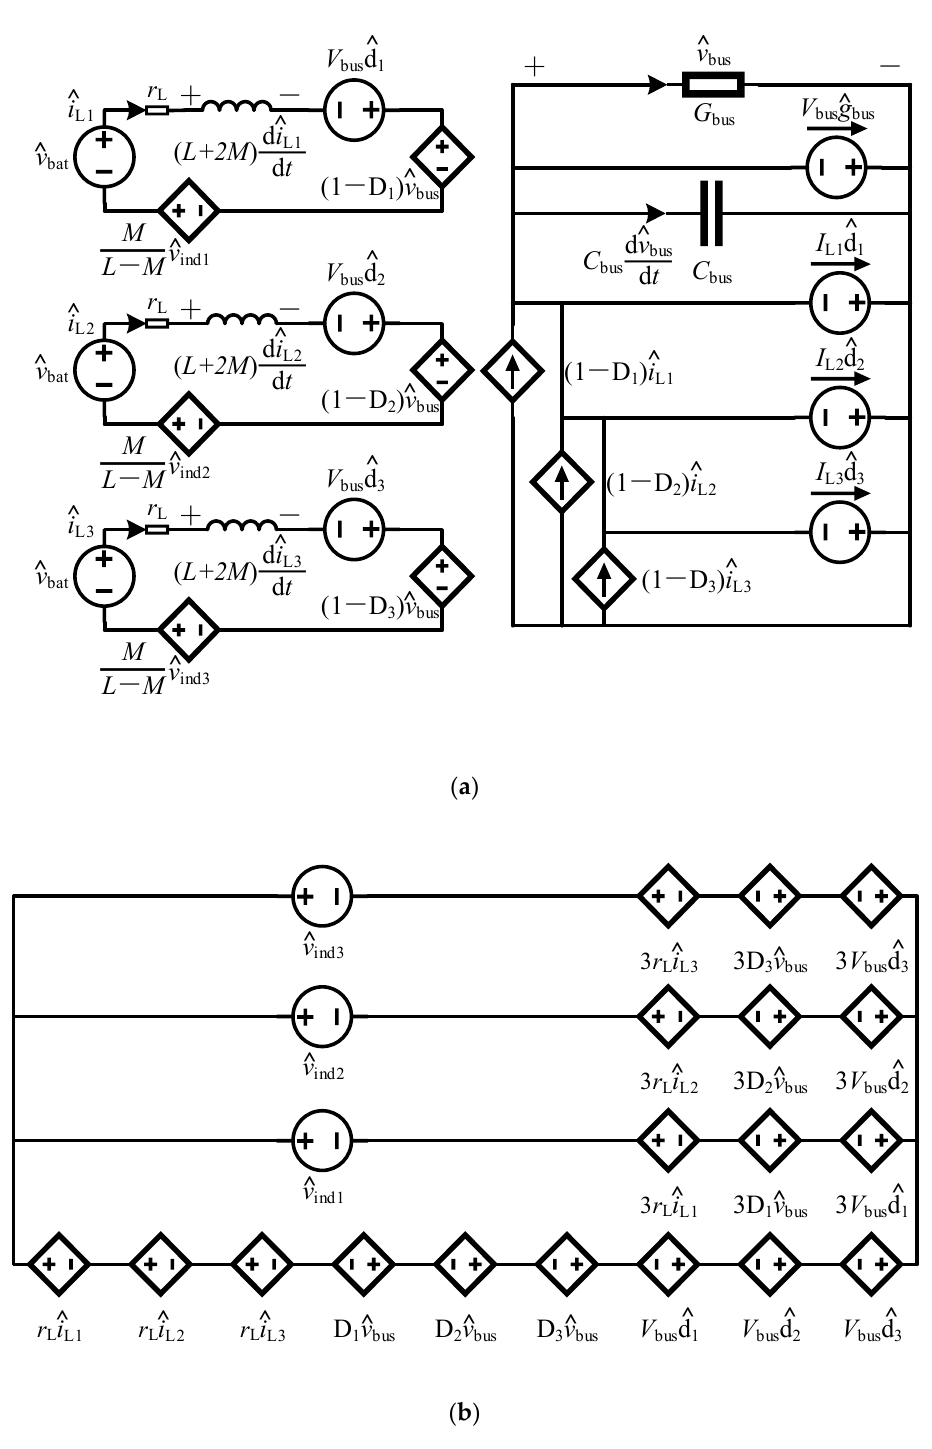
Figure 4. Equivalent circuit of 3-phase coupled buck–boost converter. ( a ) Equivalent relationship of small signal variables. ( b ) Equivalent induced voltage in coupled inductor.